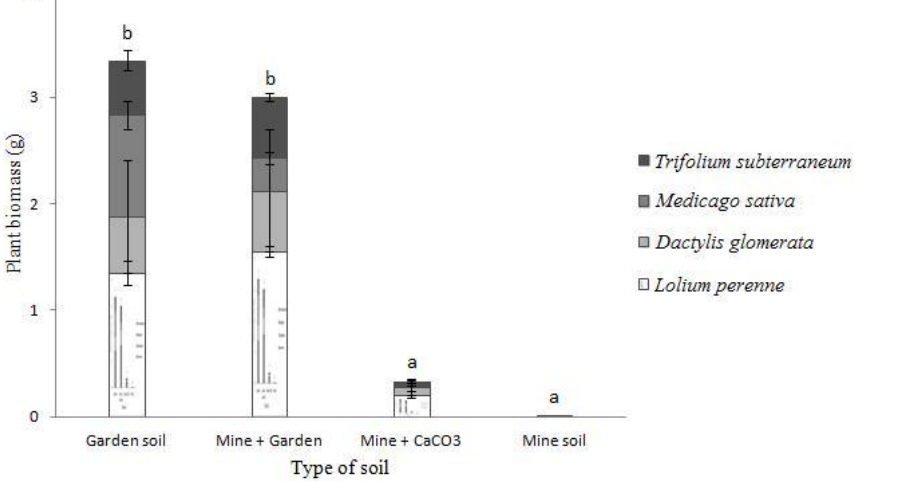
Figure 6. Total aboveground biomass (mean ± SE) in each treatment at the end of the mixture of species experiment. Di ff erent letters above the bars mean significant di ff erences between each soil type after ANOVA and Tukey post hoc